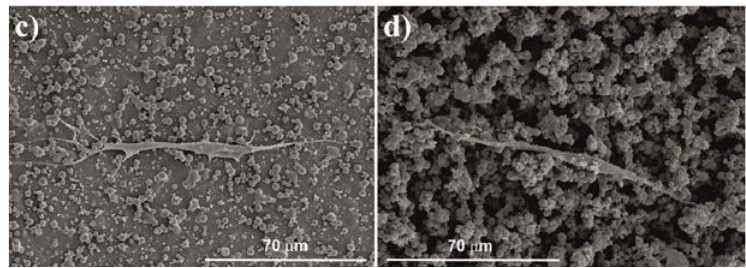
Figure 2. Overall cell morphology of hMSCs analyzed by SEM after four days of cell culture on: ( a ) glass; ( b ) β-PVDF film; ( c ) film with low density of PVDF microspheres; ( d ) film with high density of